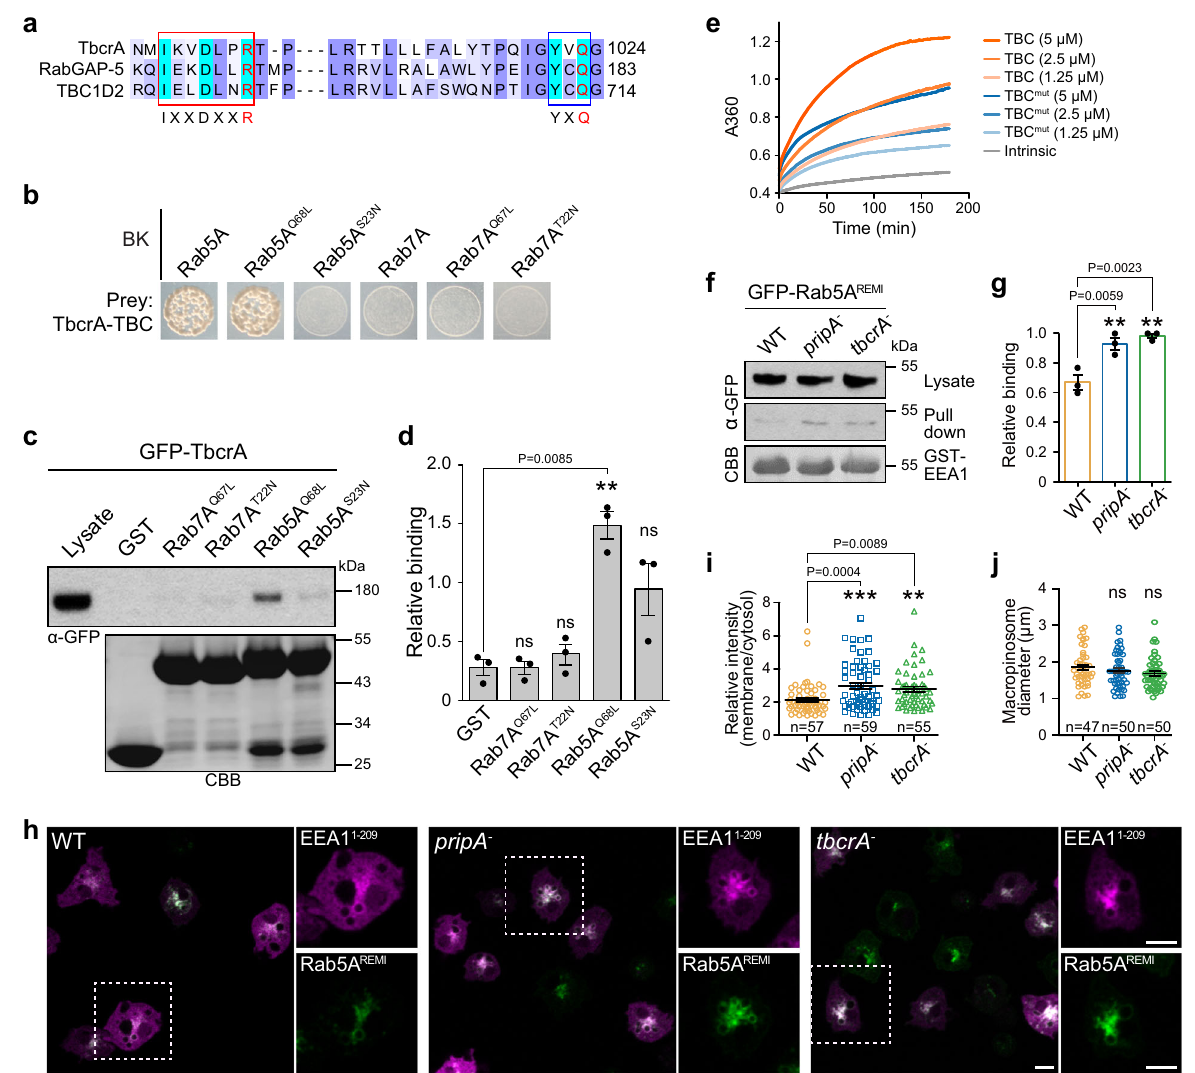
Fig. 7 The PripA-TbcrA complex promotes Rab5 inactivation. a Sequence alignment of TbcrA, human TBC1D2, and human RabGAP-5, spanning the region with conserved motifs important for GAP activity. The conserved arginine and glutamine residues are highlighted in red. b Yeast two-hybrid assay showing speci fi c interaction between TbcrA-TBC and the WT or CA form of Rab5A. c Top: Western blot from pull down of GST or GST-fused CA or DN forms of Rab5A and Rab7A beads with lysates expressing GFP-TbcrA. Bottom: the protein-transferred membrane was stained with CBB to show puri fi ed GST fusions. d Densitometry showing relative binding of GFP-TbcrA to different GST fusions (means ± SEM from three independent experiments). e Time courses of GTP hydrolysis by Rab5A in the absence or presence of TBC domain or TBC domain-containing mutations in the conserved arginine and glutamine residues (TBC mut ). Graph shows one representative experiment. The catalytic ef fi ciency was 802.2 ± 58.5M − 1 s − 1 for TBC domain and 357.2 ± 40.3 M − 1 s − 1 for TBC mut (mean ± SEM from three independent experiments). f GST-EEA1 1-209 pull-down assays in GFP-Rab5A REMI /WT cells or the same cells with deletion of pripA or tbcrA . The pull-down samples and lysates were probed with anti-GFP antibody. The protein-transferred membrane was stained with CBB to show puri fi ed GST-EEA1 1-209 . g Quanti fi cation of the relative binding of GFP-Rab5A to GST-EEA1 1-209 beads in different cell lines (means ± SEM from three independent experiments). h Localization of EEA1 1-209 -RFP in GFP-Rab5A REMI /WT cells or the same cells with deletion of pripA or tbcrA . Magni fi ed images of the areas indicated by dashed boxes are shown on the right. i Quanti fi cation of the fl uorescent intensity of EEA1 1-209 -RFP on the macropinosomal membrane relative to that in the cytosol. j Quanti fi cation of the maximum diameters of EEA1 1-209 -RFP-marked macropinosomes. The scatter plots show data points with means and SEM. Signi fi cance was determined by one-way ANOVA with Dunnett posttest in all graphs. Scale bar = 5 μ m. Source data for c – g , i , j are provided in this